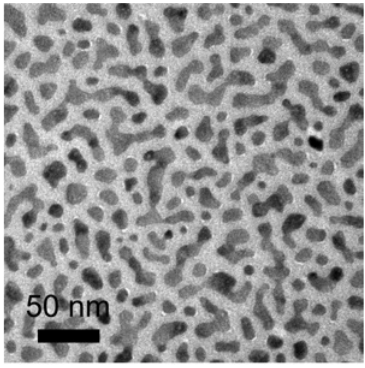
Figure 5: The plan view transmission electron microscopy image of a Al O /Bi:Al O /Al O structure grown with the same nominal 2 3 2 3 2 3 parameters as the